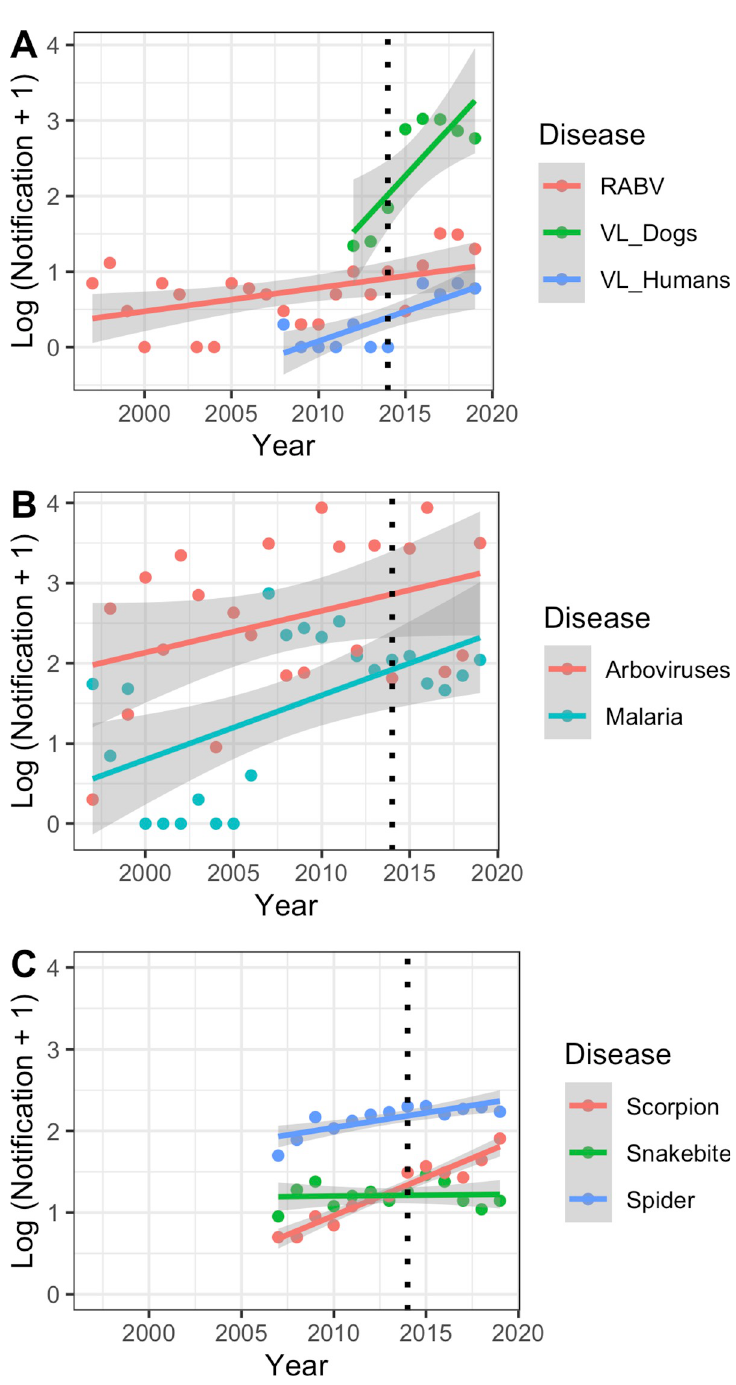
Fig 1. Disease notification in Foz do Iguac¸u from 1997 to 2019. (A) Zoonotic diseases. RABV relates to the sum of rabies notifications in dogs, cats, and bats (since 2005, only bats were found with RABV). (B) Vector-borne diseases. Arboviruses relate to the sum of dengue, Zika, and chikungunya cases; the last two arrived in Foz do Iguac¸u only in 2015. (C) Injuries of venomous animals. Incidents related to bees and caterpillars were omitted from the graphs due to their low occurrence. We transformed the raw data by adding +1 to avoid issues with 0 cases.